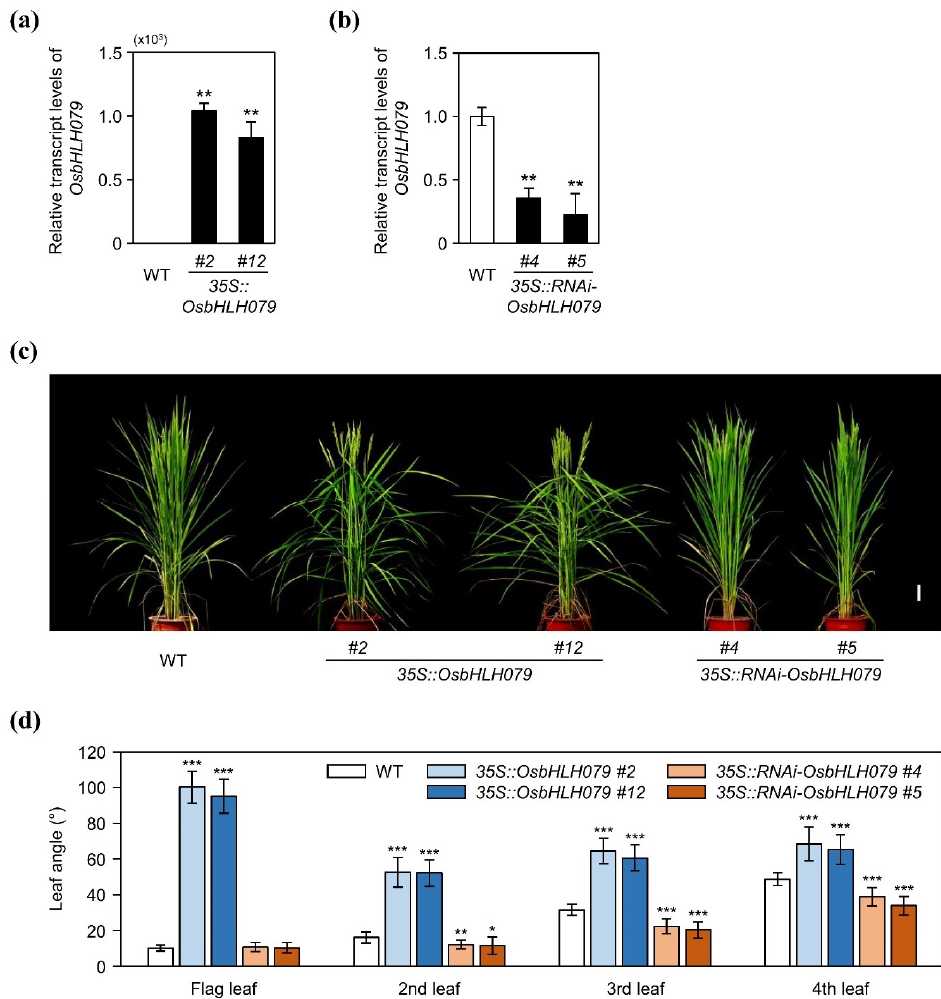
Figure 2. The leaf angles of WT, 35S::OsbHLH079 , and 35S::RNAi-OsbHLH079 . ( a ) Relative transcript levels of OsbHLH079 in WT, 35S::OsbHLH079 #2 , and 35S::OsbHLH079 #12 . ( b ) Relative transcript levels of OsbHLH079 in WT, 35S::RNAi-OsbHLH079 #4 , and 35S::RNAi-OsbHLH079 #5 . ( a , b ) Total RNA was extracted from the 2-cm lamina joint tissues between the leaf blade and leaf sheath of WT, 35S::OsbHLH079 #2 , 35S::OsbHLH079 #12 , 35S::RNAi-OsbHLH079 #4 , and 35S::RNAi-OsbHLH079 #5 at heading stage in plants grown under NLD conditions in the paddy field. Relative expression levels of OsbHLH079 were determined by RT-qPCR analysis and normalized to UBQ5 . Means and standard deviations were obtained from five biological replicates. Differences between means were compared using Student’s t -test (** p < 0.01). ( c ) Plant phenotypes of WT, 35S::OsbHLH079 #2 , 35S::OsbHLH079 #12 , 35S::RNAi-OsbHLH079 #4 , and 35S::RNAi-OsbHLH079 #5 at heading stage in plants grown under NLD conditions in the paddy field. Scale bar = 10 cm. ( d ) Statistical analysis of leaf angles among WT, 35S::OsbHLH079 #2 , 35S::OsbHLH079 #12 , 35S::RNAi-OsbHLH079 #4 , and 35S::RNAi-OsbHLH079 #5 at heading stage in plants grown under NLD conditions in the paddy field. Means and standard deviations were obtained from ten biological replicates. Significant differences between means were analyzed using Student’s t -test (* p < 0.05, ** p < 0.01, *** p < 0.001). These experiments were repeated twice with similar results.